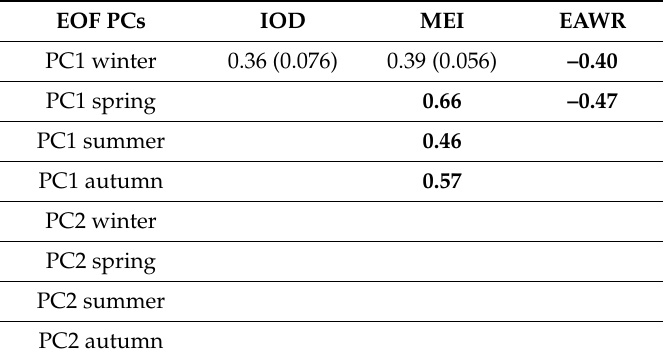
Figure 4. The times series of the principal components corresponding to the Empirical Orthogonal Function (EOF) modes. ( a – d ) are the revolution of PC1 during winter, spring, summer, and autumn, respectively; and, ( e – h ) is the same, but for PC2. The green circle the La Niña event. The IOD is multiplied by 2.5. Table 2. The correlation between the PC1, 2 and time series of di ff erent climate modes. Bold indicates significance at